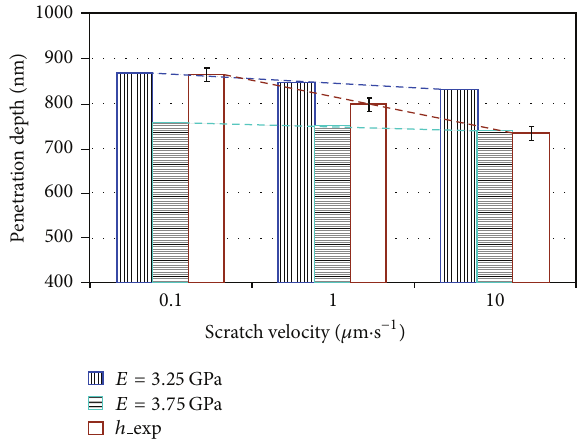
Figure 6: Comparison of experimental results ( ℎ exp) and numeri- cal results for 𝐹 𝑛 = 20 mN. The data denoted by 𝐸 = 3.25 GPa (resp., 𝐸 = 3.75 GPa) are those calculated with the elastic-viscoplastic model in using a Young modulus of 3.25 GPa (resp., 3.75